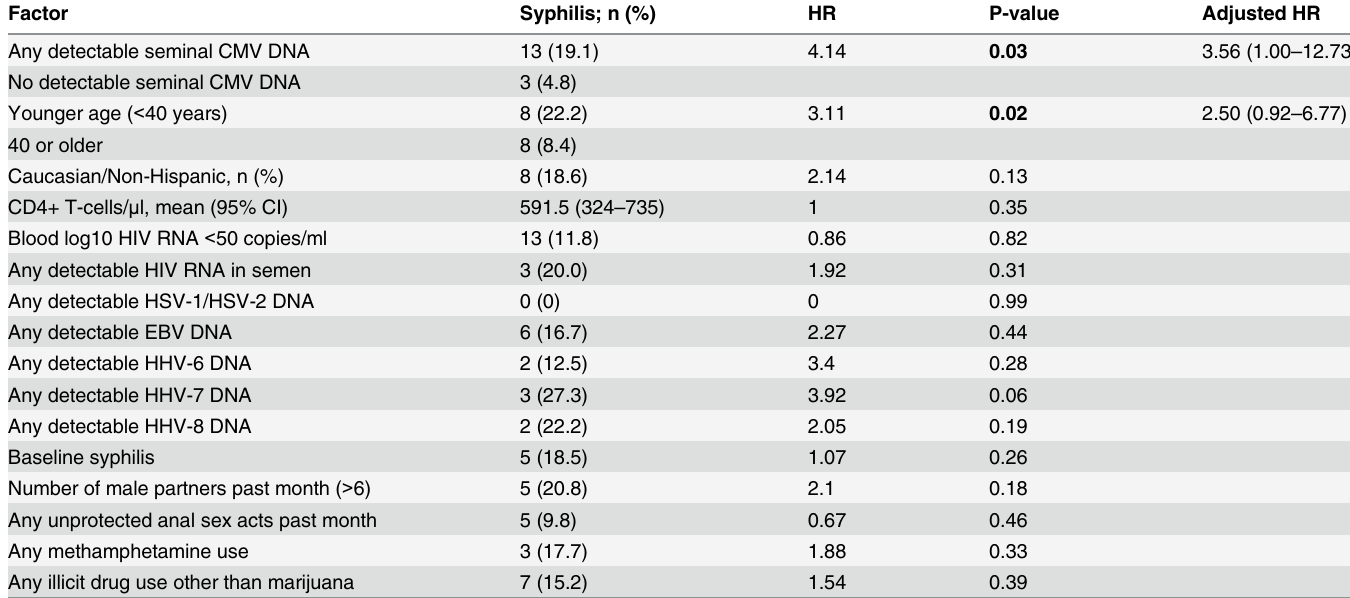
Table 2. Factors associated with incident